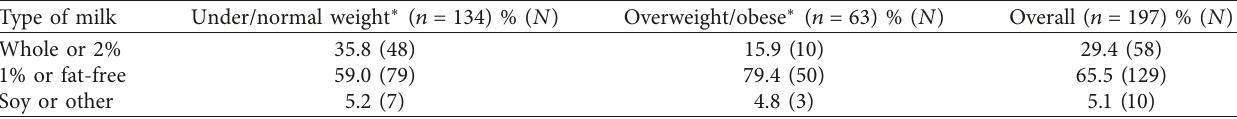
Table 3: Proportion of type of milk most often consumed by weight category combined in WIC participating preschool children. Type of milk